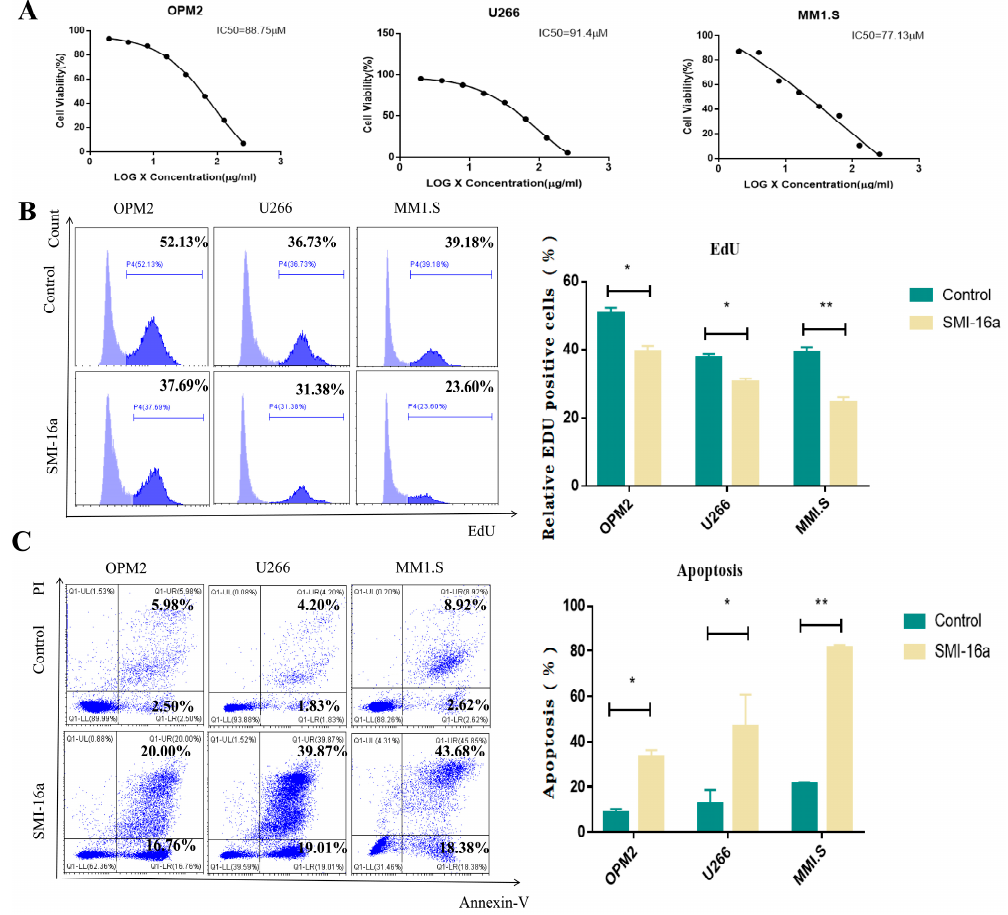
Figure 3. SMI-16a inhibited cell proliferation and induced cell apoptosis in MM cells. ( A ). Cell viability of MM cell lines treated with increasing concentrations of SMI-16a for 48 h. ( B ). EdU